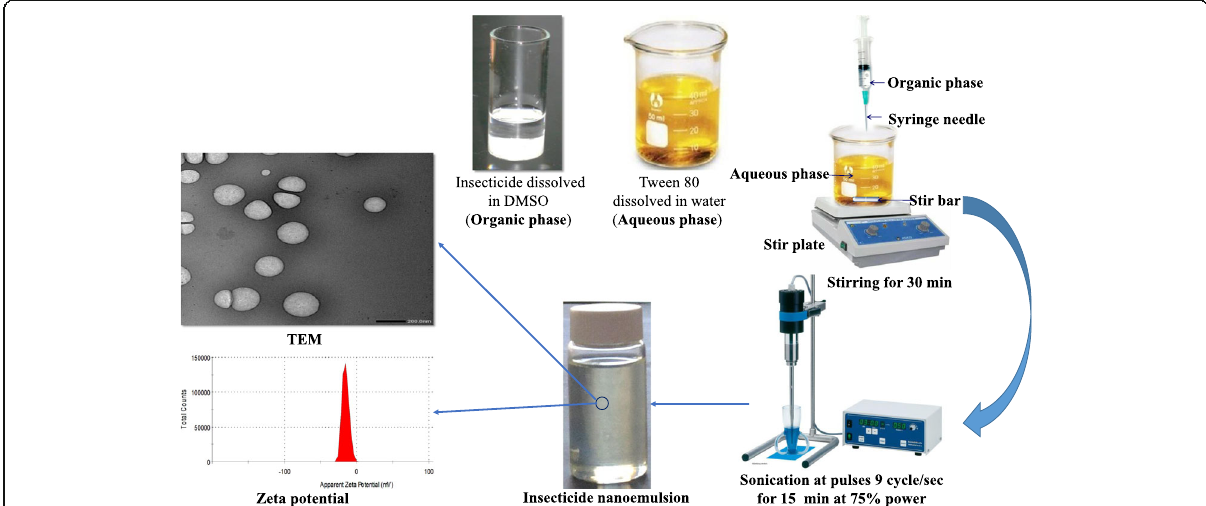
Fig. 1 Schematic illustration of the preparation and characterization of pyrethroid